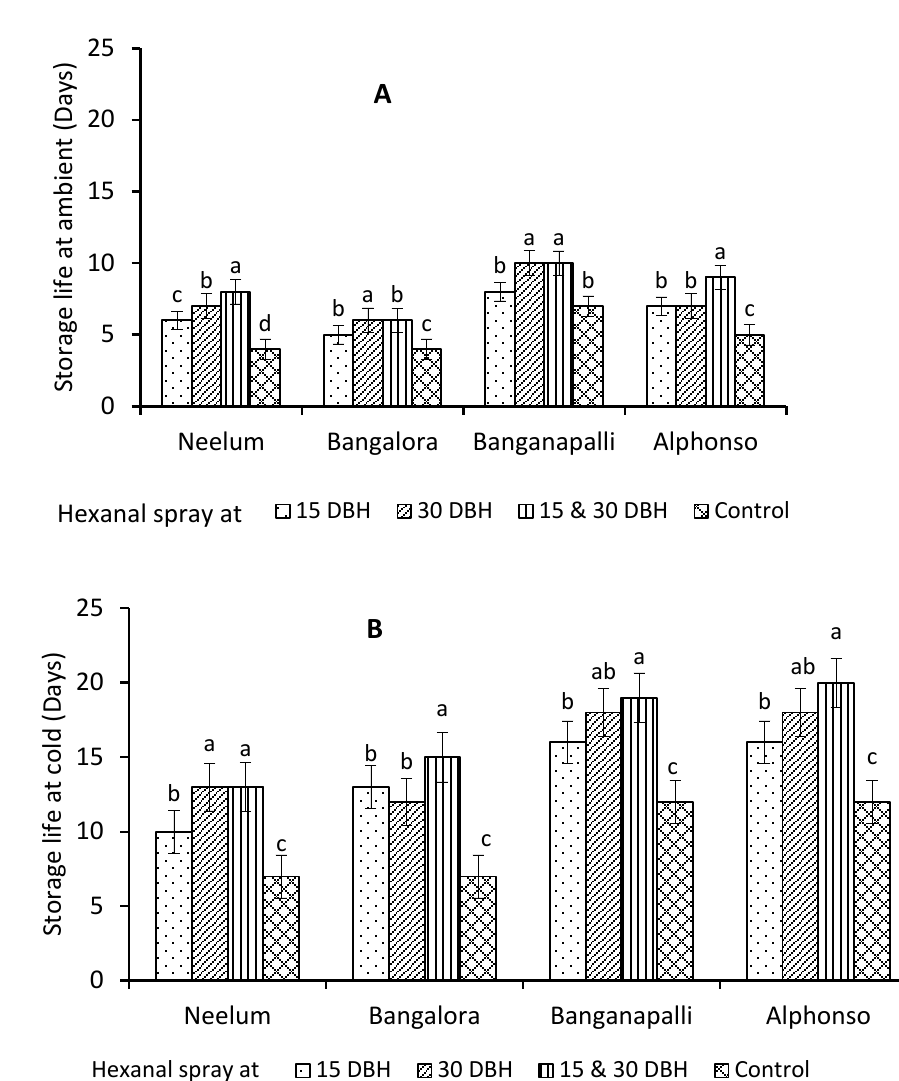
Figure 1. Mean storage life of hexanal-treated and control mango fruits of different cultivars under ambient ( A ) and cold ( B ) storage conditions. The vertical bars in the columns represent the standard error of four replicates (n = 15). Columns with different and the same letters indicate statistical significance and non-significance, respectively ( p = 0.05). DBH — Days before harvest.